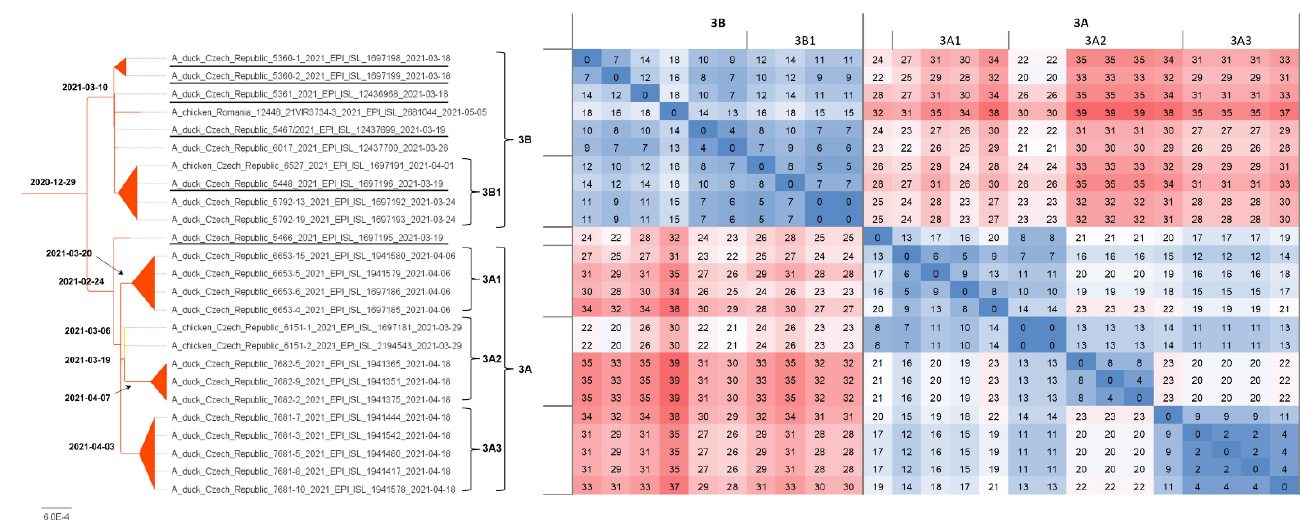
Figure 3. Phylogenetic dating. Concatenated ML tree with the most probable divergence time estimated using the LSD approach (bold). The tree was rooted to the A/chicken/Iraq/1/2020 H5N8 strain. For clarity, only the subtree including H5N8 strains from commercial poultry (see Figure 2) was presented along with a nucleotide sequence difference count matrix in absolute values as a heatmap.